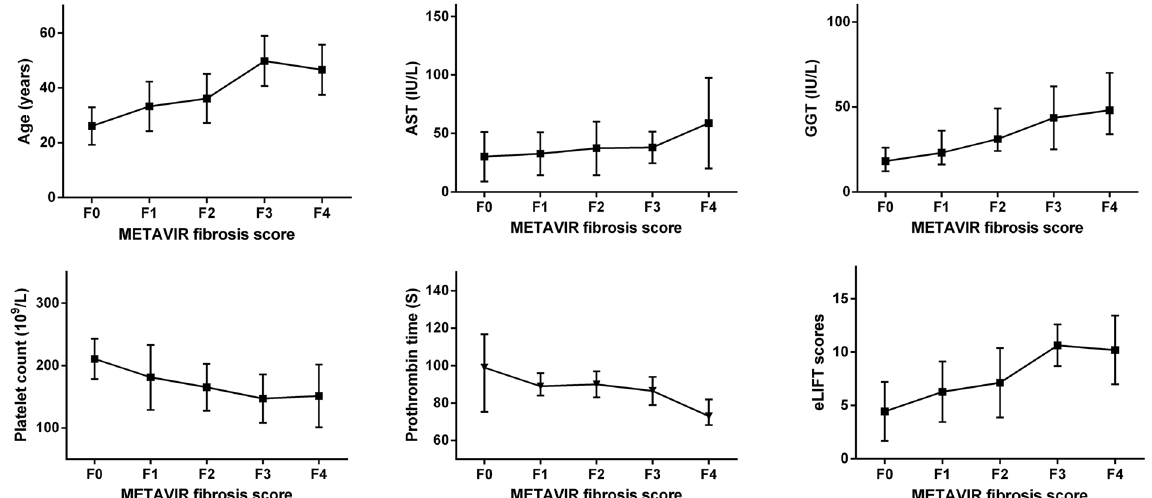
Figure 2. Association between noninvasive markers and METAVIR fibrosis stages. AST, aspartate transaminase; GGT, gamma-glutamyl transpeptidase; eLIFT, the easy Liver Fibrosis Test. The METAVIR fibrosis stages had positive correlation with age, AST, GGT, and eLIFT scores; but negative correlation with platelet count and prothrombin time. The higher median age, AST, GGT, and eLIFT scores, but lower platelet count levels and prothrombin time with increasing METAVIR fibrosis stages.